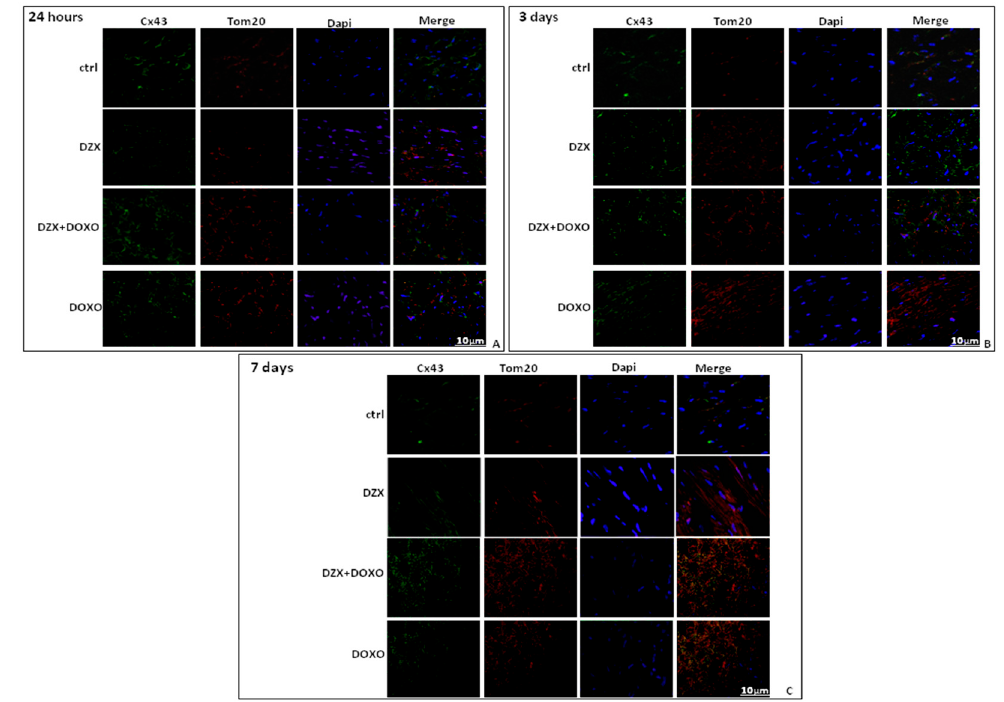
Figure 4. Effect of DOXO or DZX or combined DZX+DOXO treatment on Cx43 localization. C57BL/6j mice received a single administration (1st group), two administrations (2nd group), or three administrations (3rd group). Frozen myocardial tissue sections were stained with Anti-Cx43 (green), TOM20 (red) and nucleus with DAPI (blue) and were determined by Immunofluorescence assay at confocal microscopy for mitoCx43 localization. Scale bar 10 μ m.